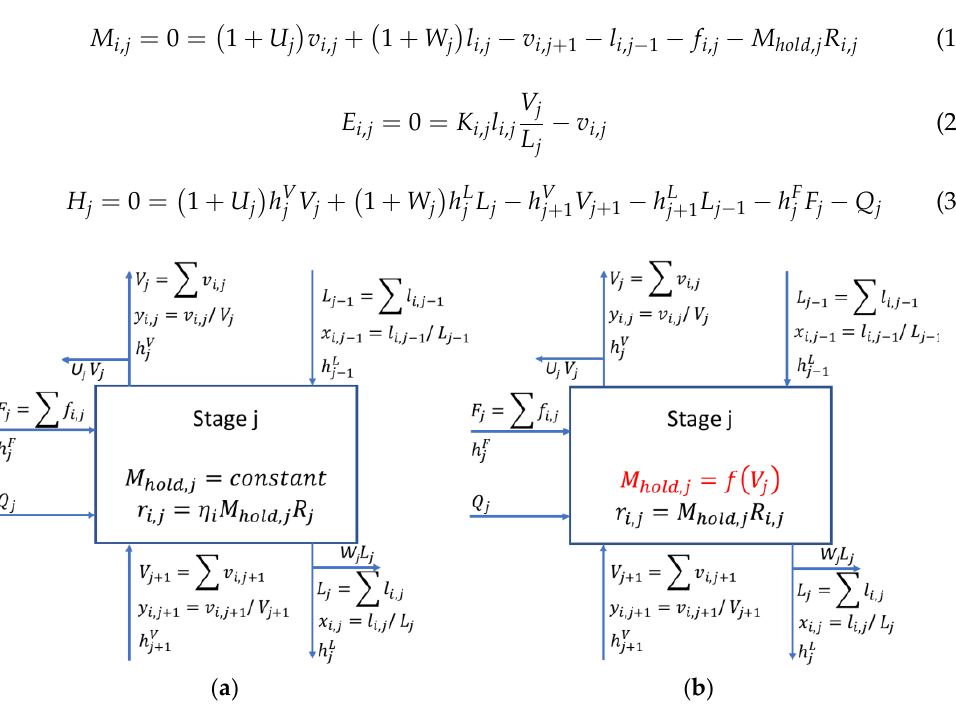
Figure 1. Schematic overviews of the equilibrium stage model ( a ) and the proposed extension ( b ) for reactive distillation. The holdup function in ( b ) is the simplified form derived from Equation (4).